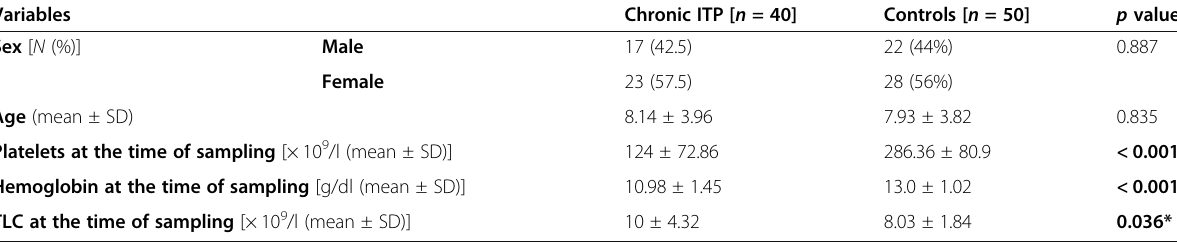
Table 2 Comparison between chronic PIT patients and healthy controls as regard demographic, clinical, and laboratory data Variables Chronic ITP [ n = 40] Controls [ n = 50] Sex [ N